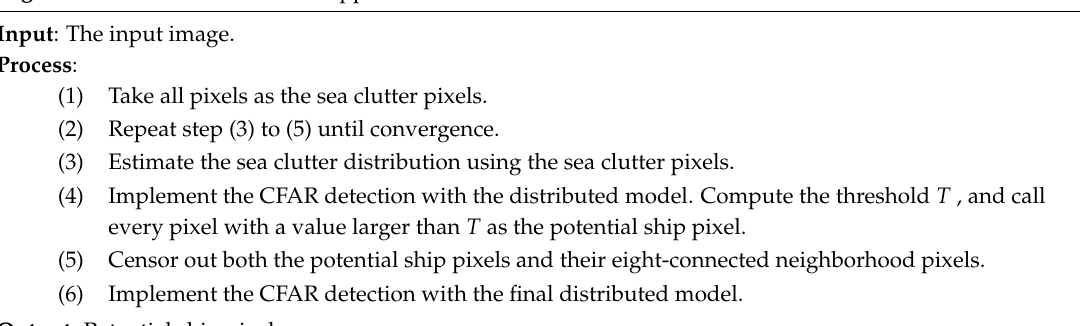
Algorithm 1 The Iterative CFAR Approach